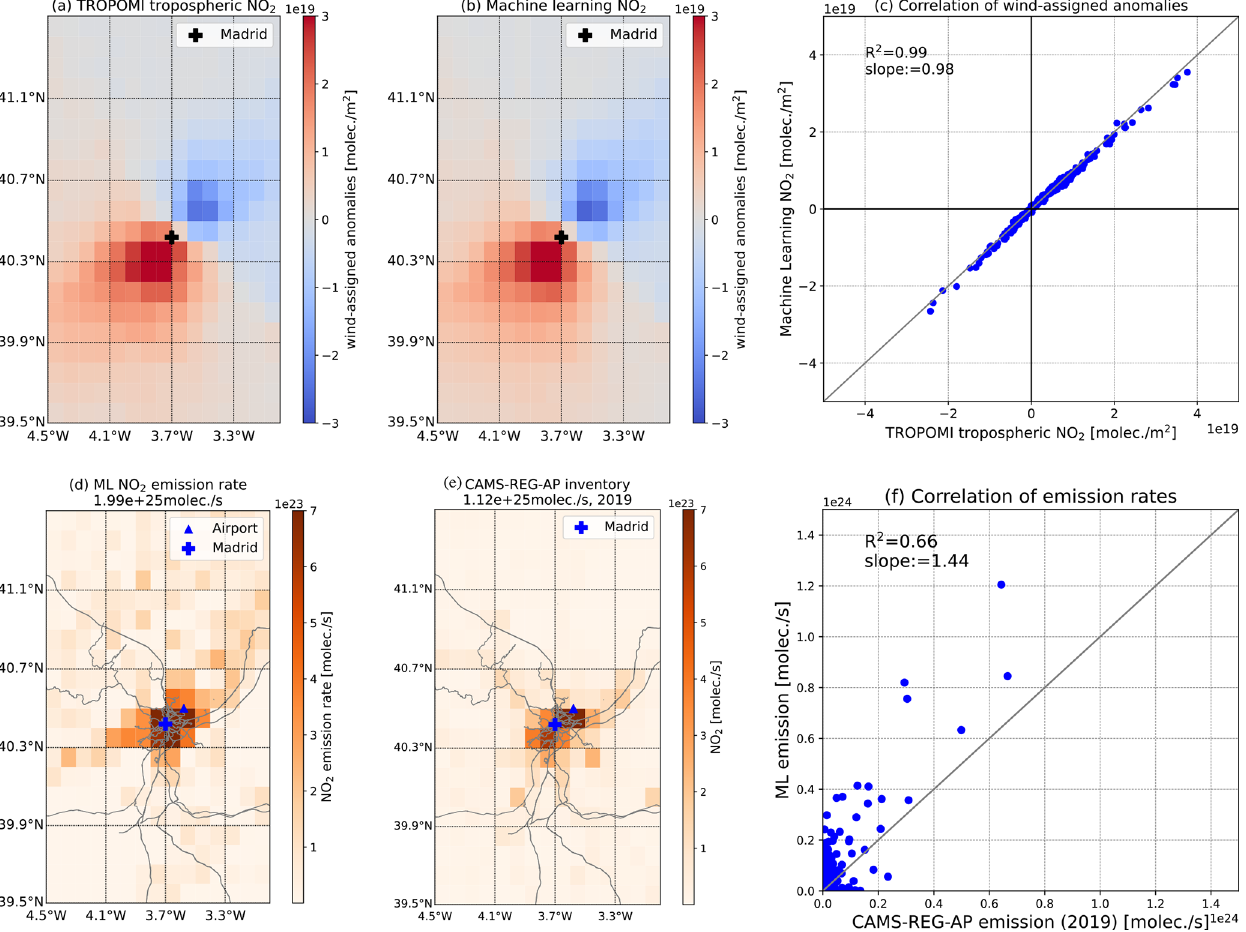
Figure 2. Panels (a) – (d) show the same information as Fig. 1a–d, respectively, but for the Madrid area in Spain. Panel (e) presents the spatial distribution of the CAMS-REG-AP inventory in 2019, and panel (f) shows the correlation of emission rates between ML and the CAMS-REG-AP